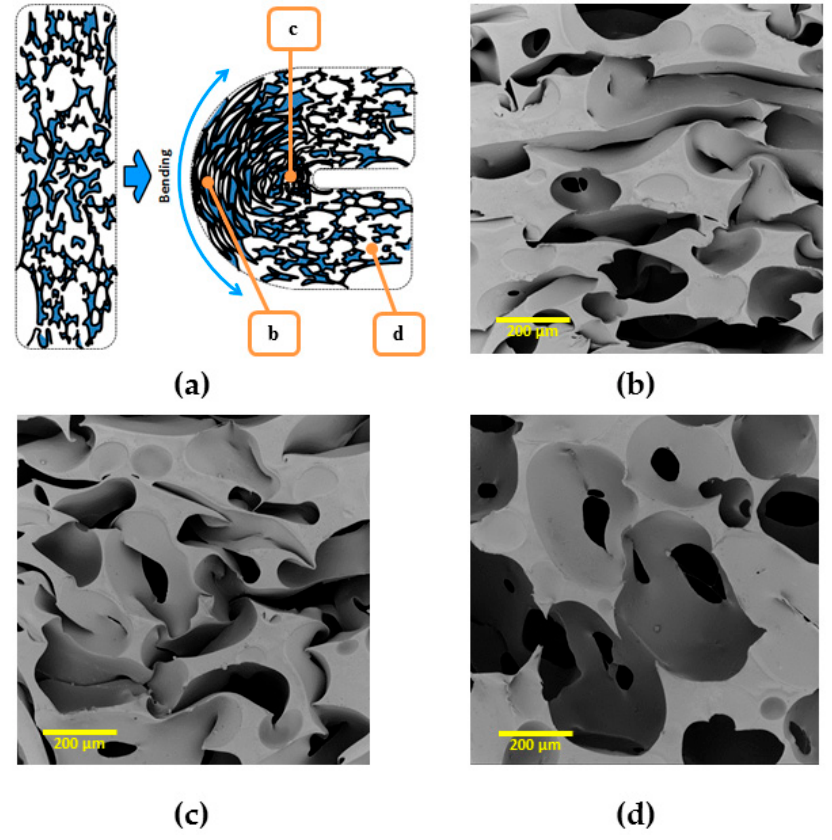
Figure 14. ( a ) Scheme of foam programming by bending; and ( b – d ) SEM pictures of the cPCL-2/4/8k-180 programmed via bending at corresponding places in bended foam specimen: ( b ) SEM image of outer side of the bend; ( c ) SEM image of innerside of the bend; and ( d ) SEM image outside the bend; scale bar is 200 µm.